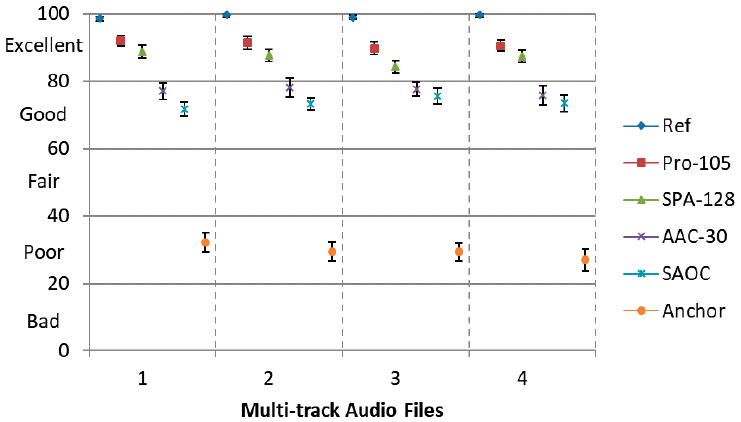
Figure 9. MUSHRA test results with 95% confidence intervals for the soundfield rendering using separate AAC encoding at 30 kbps, SAOC, SPA and our proposed approach at 105 kbps.